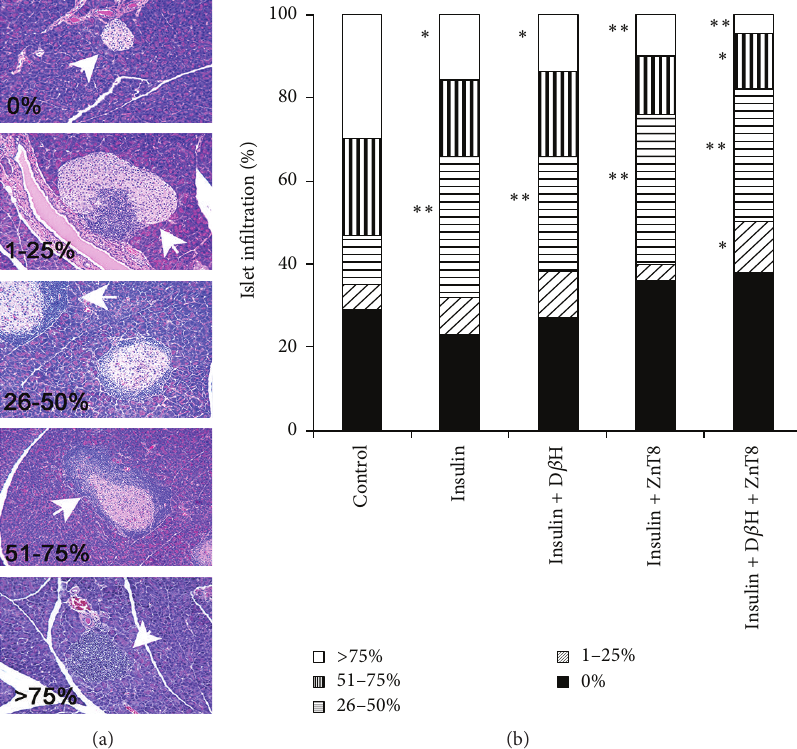
Figure 4: Pancreas histology. Mice from Figure 2(d) were examined after H + E staining of pancreases. Insulitis was assessed by measuring the volume of islet mass obscured by lymphocytic infiltration. Examples of classification of infiltration are shown in (a) and the percentage of islets with 0, 1–25, 26–50, 51–75, and > 75% infiltration is shown in (b). 10–20 microscopic fields (containing at least 100 islets) were examined for each treatment group. Groups were compared to control by ANOVA with post hoc comparison. ∗ 𝑃 = 0.05 , ∗∗ 𝑃 = 0.01